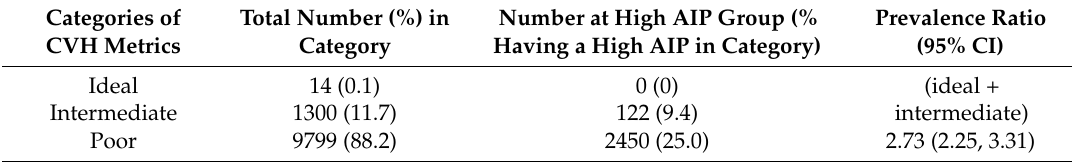
Table 5. Prevalence and prevalence ratios of having a high AIP according to CVH categories a